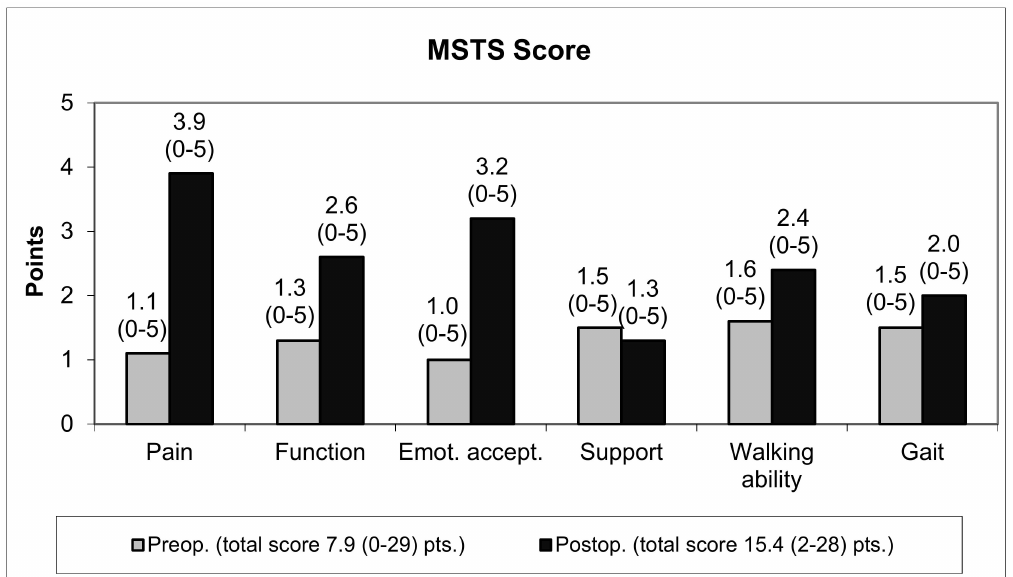
Figure 5. Functional outcome—MSTS